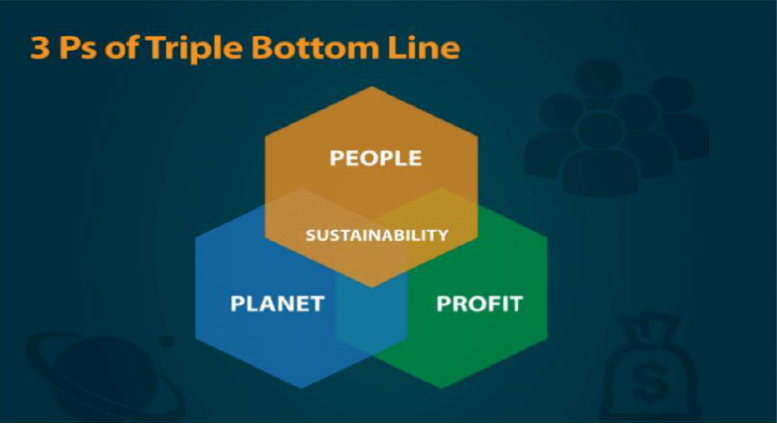
Figure 1. The 3Ps of sustainability (planet/people/profit).